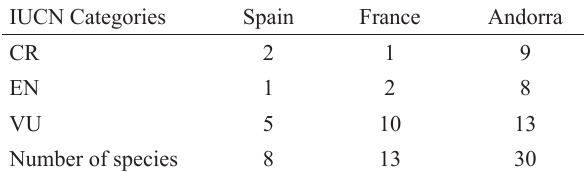
Table 1. Total number of AFC species of the three RL for each category.